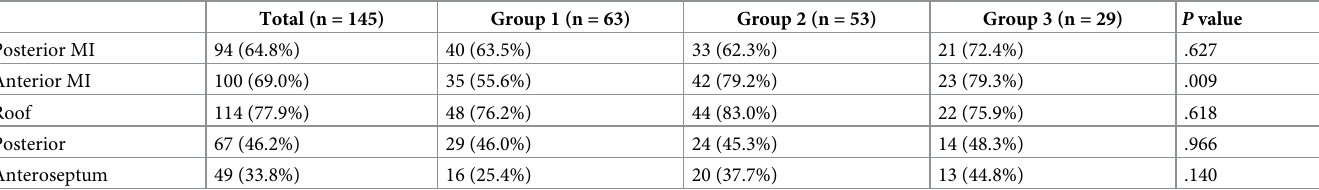
Table 4. Summary of patient numbers at different locations of left atrial linear ablation among three groups.